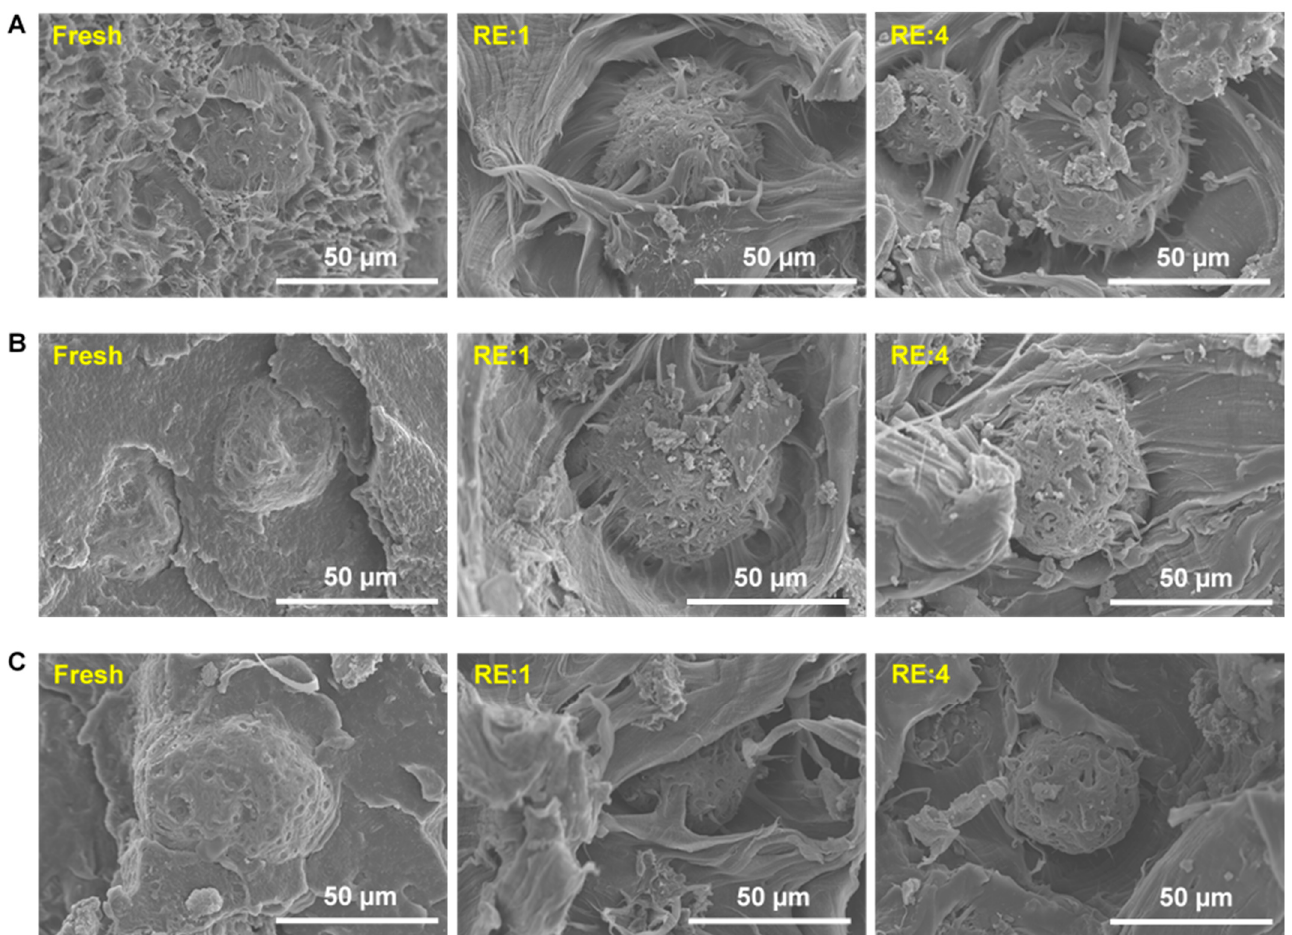
Figure 5. SEM images of cryogenically fractured fresh and recycled composites: ( A ) FA1/HDPE, ( B ) FA2/HDPE, and ( C ) FA3/HDPE.